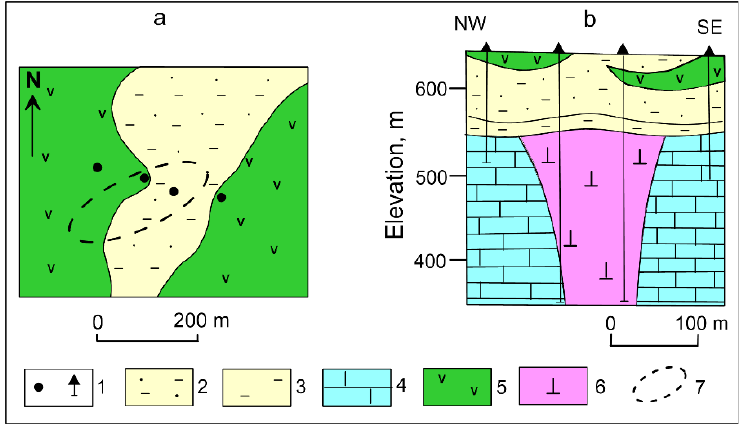
Figure 4. Layout of the pipe TSNIGRI ( a ) and the section through the pipe ( b ). 1 — wells, 2 — sandstones and siltstones, 3 — carbonaceous siltstones, 4 — carbonate rocks, 5 — dolerites, 6 — kimberlites, 7 — contour of the pipe.